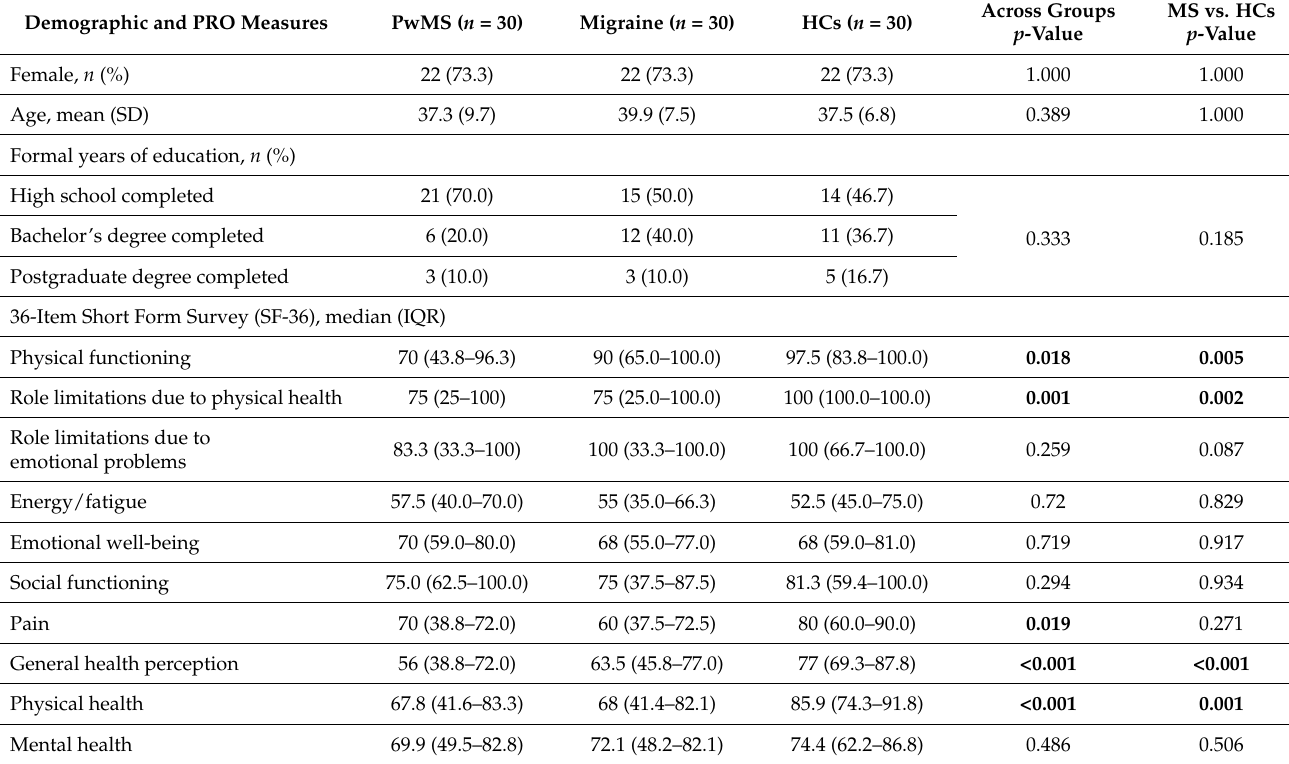
Table 1. Demographic and patient-based outcomes in the study